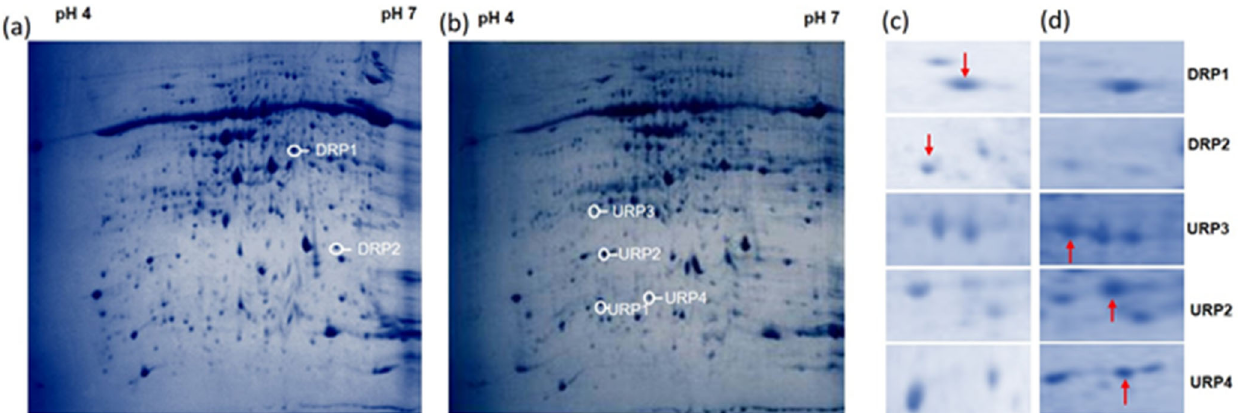
Figure 4. R. solani ‐ induced proteome shift in wild rice accession O. grandiglumis : total proteins were extracted from wild rice accession O. grandiglumis and analyzed by 2 ‐ DE protein electrophoresis. In panel ( a ): complete 2D protein profile of wild rice O. grandiglumis without R. solani infection. In panel ( b ): complete 2D protein profile of wild rice accession O. grandiglumis 48 h post ‐ inoculation of